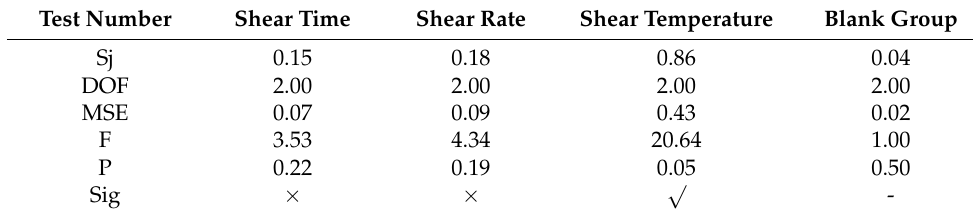
Table 11. Penetration variance results.